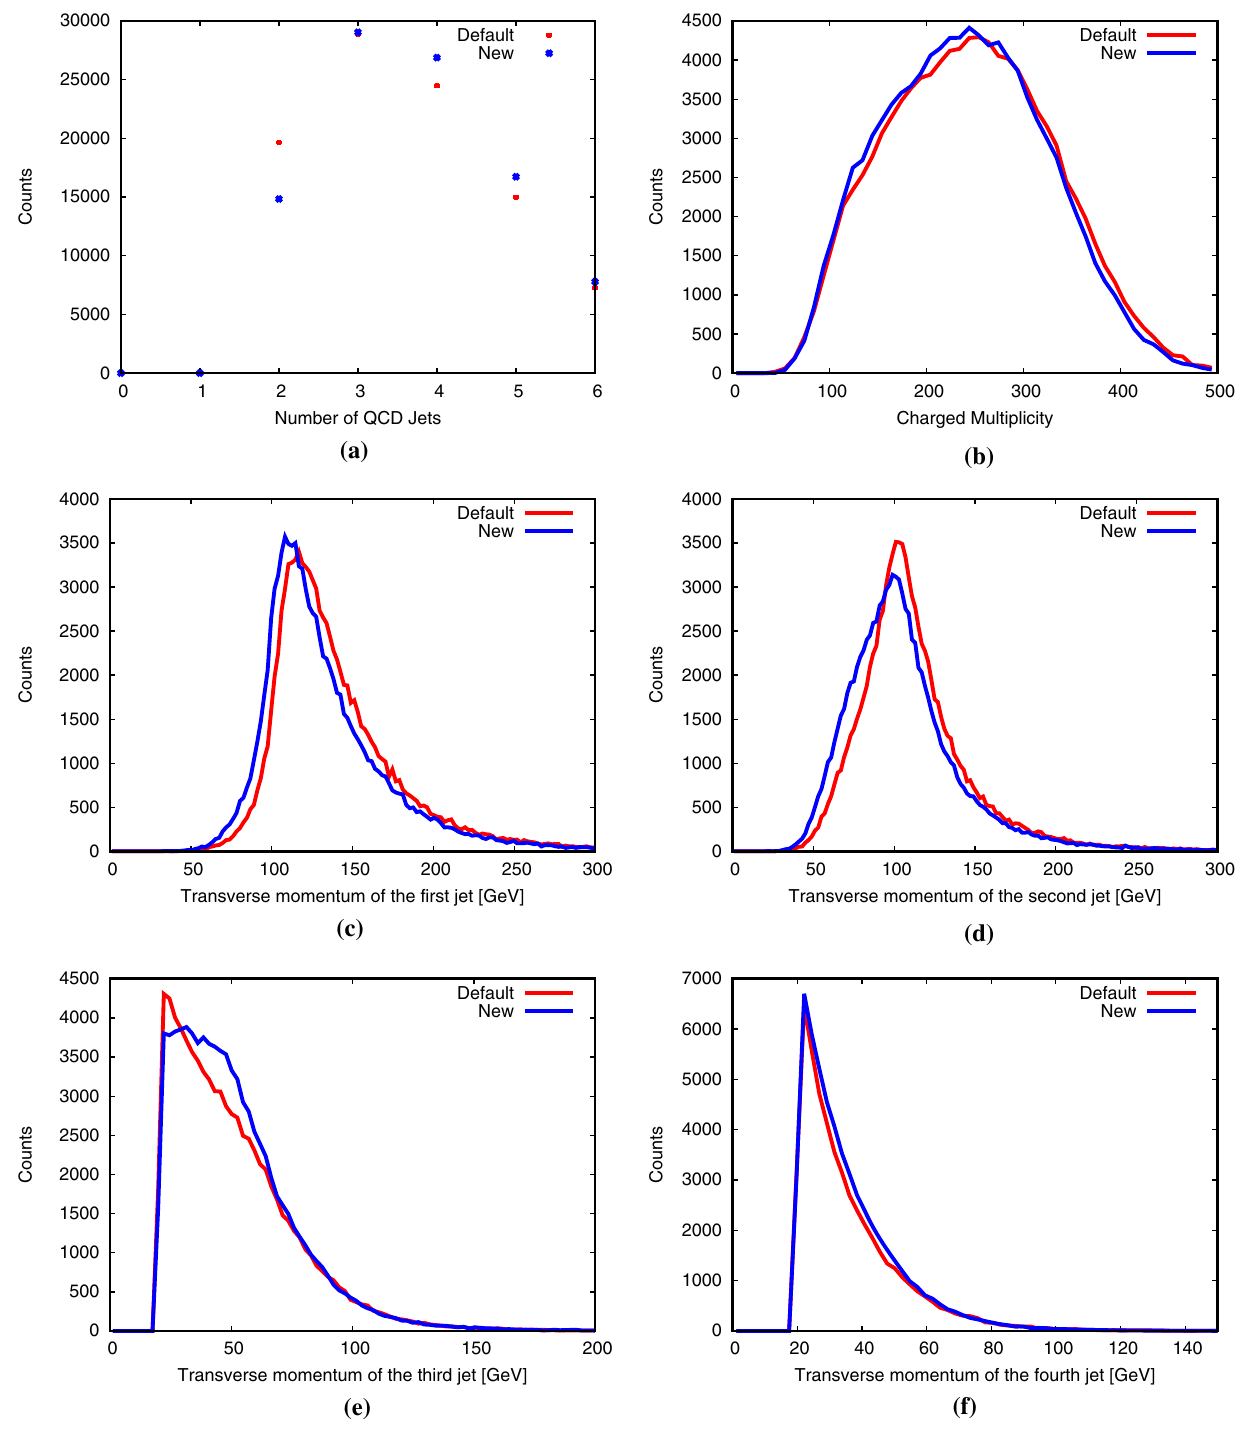
Fig. 13 Comparison of shower algorithm results for the toy study described in the text: a number of QCD jets, b charged multiplicity, transverse momentum of the c first jet, d second jet, e third jet, f fourth jet dence on the colour dipole masses. In the new dipole shower the difference is much more pronounced, however. Even if the p ⊥ evol scale of the shower evolution is constrained from above by the p ⊥ scale of the hard 2 → 2 process in both